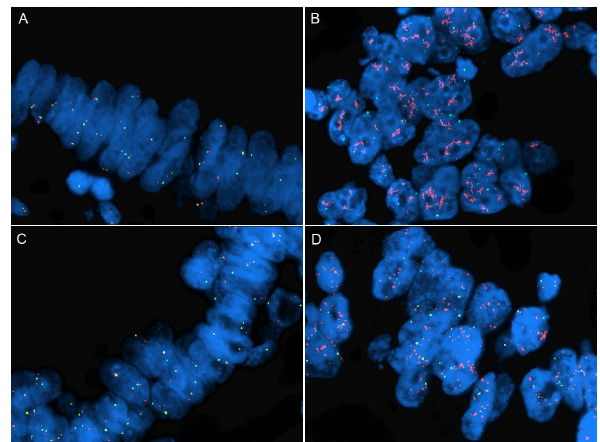
Figure 2. Heatmap Depicting the Correlation between Total CNA Count in Each Tumor and Total Copy Number Gains, Total Copy Number Losses and Total CNA Count by Chromosome. Cases are ordered from lowest to highest total CNA count down the left-most column. Lowest counts in each column are blue and the highest counts in each column are red as illustrated in the color scale below. In adjacent columns, the heatmap shows the correlation of total CNA count with total copy number gains, total copy number loss and total CNA count by chromosome. The heatmap illustrates that as total CNA count increases, the frequency of gains and losses increase and the frequency of CNA counts tends to increase throughout all chromo- somes. Correlation coefficients for each column with total CNA count (Pearson’s r) are listed below with the corresponding p-values.